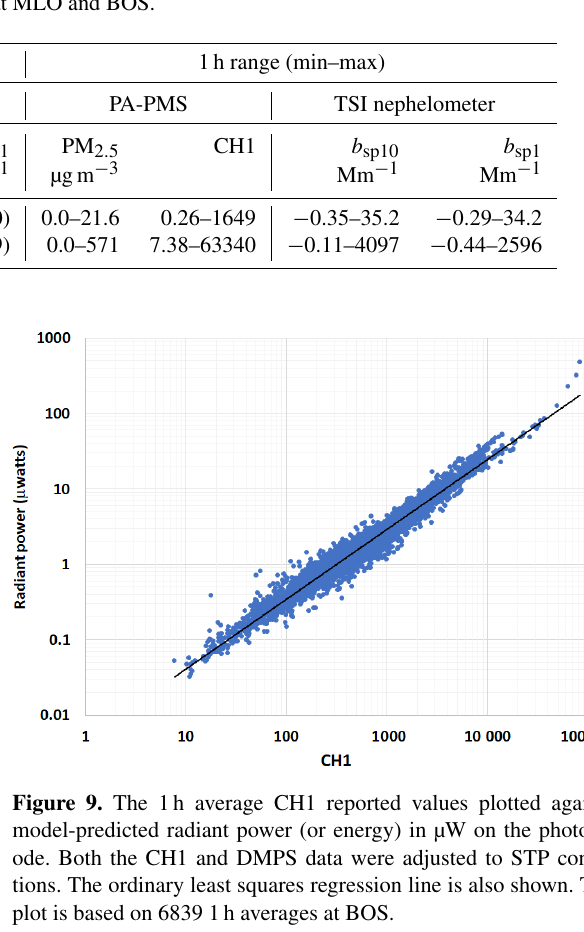
Table 2. Summary of PA-PMS and nephelometer hourly observations at MLO and BOS.